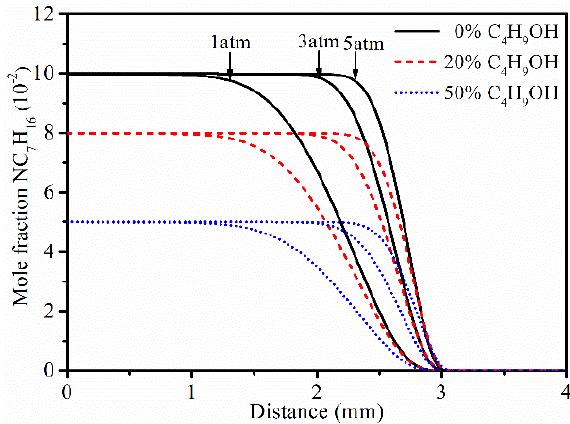
Figure 2. Mole fractions of NC 7 H 16, with different levels of n -butanol at different pressures. The rate of consumption of n -heptane with 0%, 20%, and 50% butanol addition was presented in Figure 3. The dominant consumption reactions of n -heptane were R742: NC 7 H 16 = 0.2CH 3 + 0.4C 2 H 5 + 0.4NC 3 H 7 + 0.4NC 4 H 9 P + 0.5NC 5 H 11 + 0.1NC 7 H 15 and R2584: NC 7 H 16 + H = H 2 + NC 7 H 15 . Figure 3a,b shows the influence of R742 and